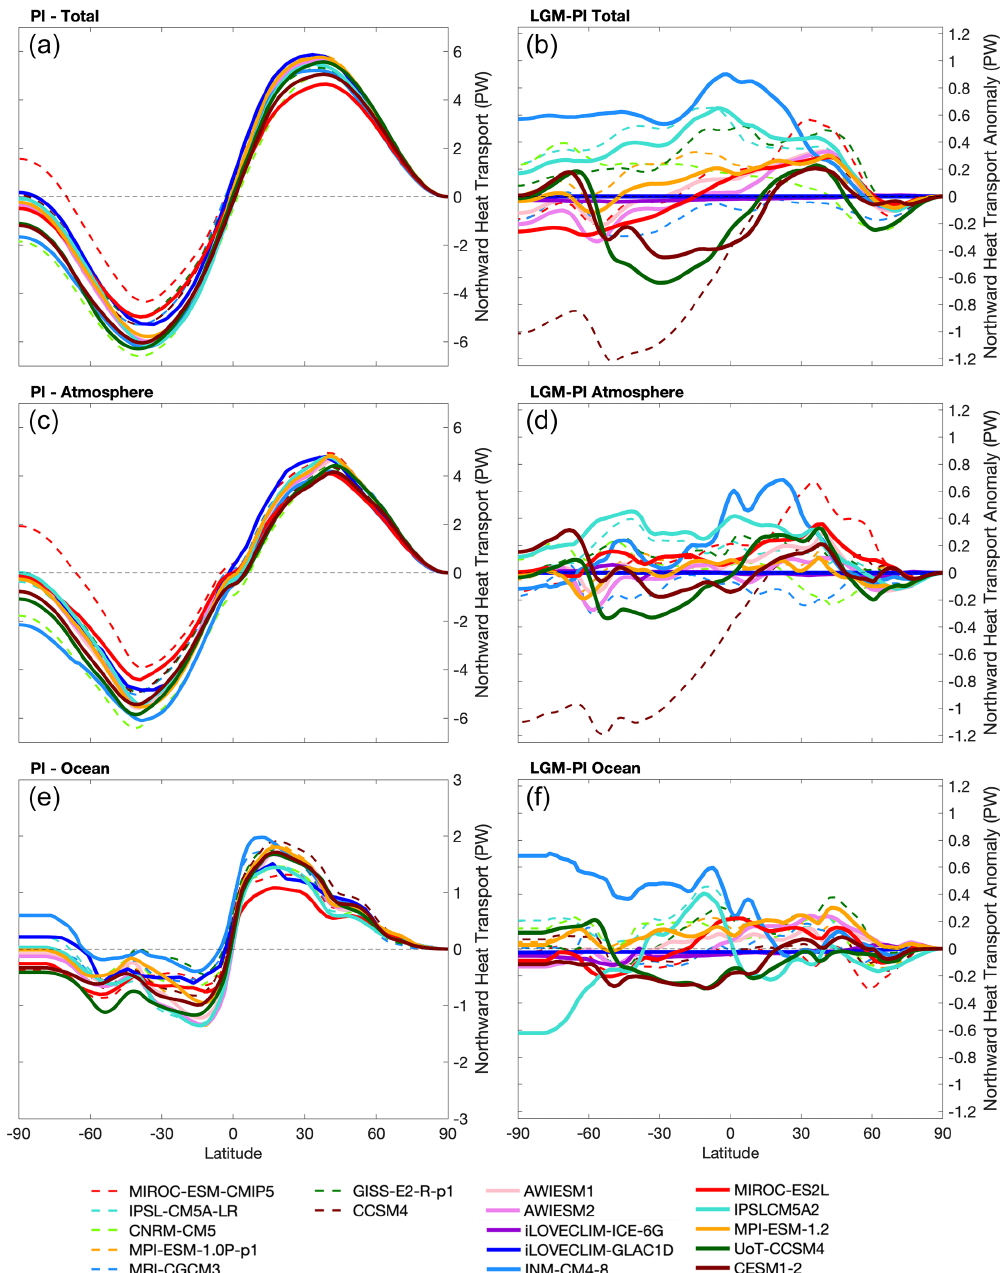
Figure 5. Meridional energy transport for the PI reference state (left-hand side) and LGM–PI anomaly (right-hand side). (a, b) Total energy transport, (c, d) atmospheric energy transport, (e, f) oceanic energy